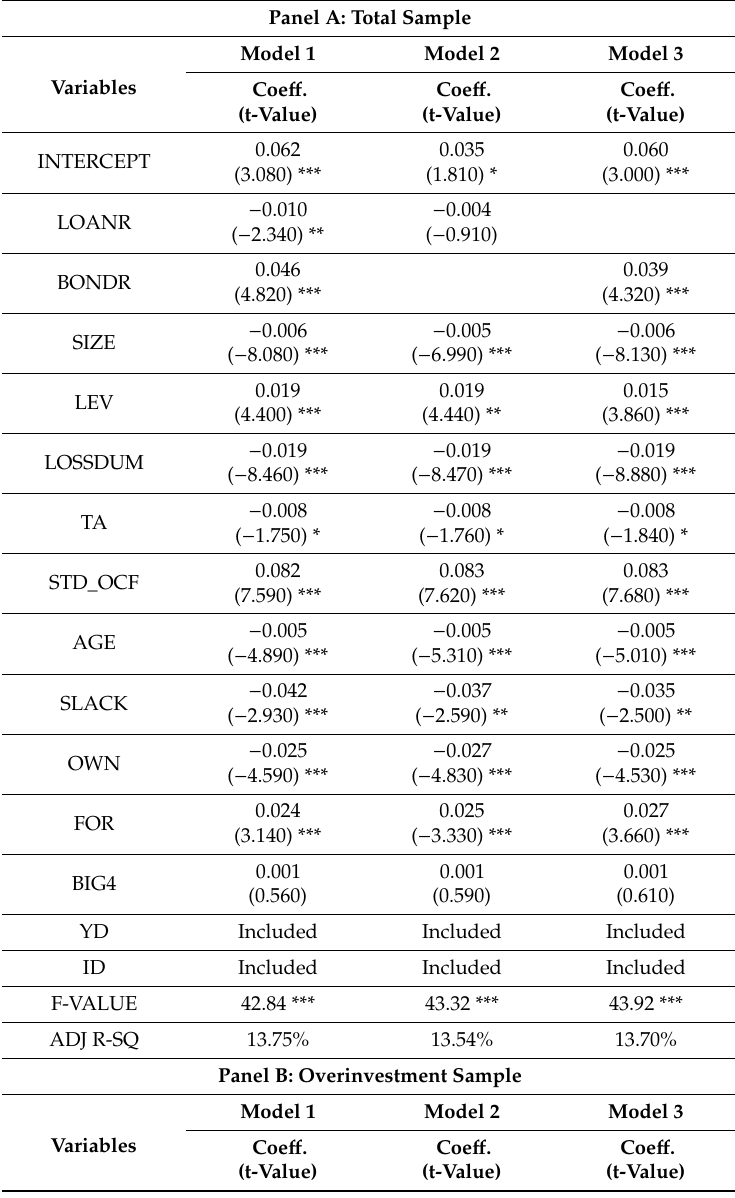
Table 8. Debt origin and investment e ffi ciency: analysis results scaled to total liabilities instead of total